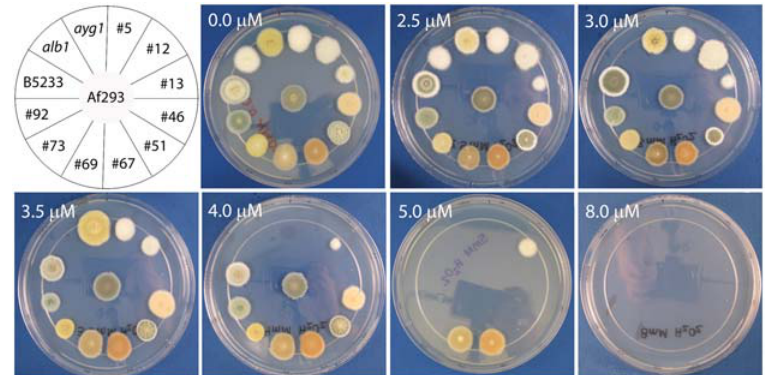
Figure 9. Color mutants display varied sensitivity towards hydrogen peroxide. A. fumigatus strains were cultured on YNB agar medium with 0 m M, 2.5 m M, 3.0 m M, 3.5 m M, 4.0 m M, 5.0 m M, and 8.0 m M H 2 O 2 for 3 days at 30 u C. Color mutants # 12, # 67, and # 69 demonstrate an increased resistance to oxidative stress.